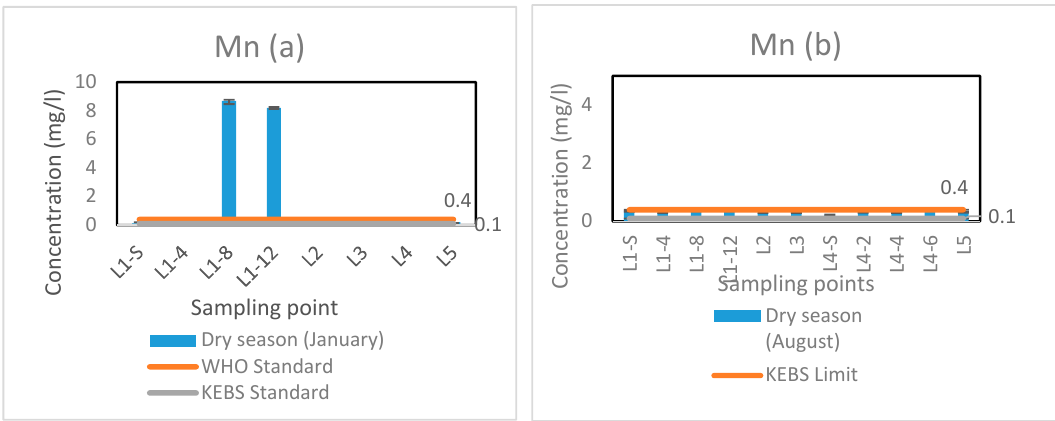
Figure 11. Manganese concentration at various sampling points: ( a ) January and ( b ) August. The mean concentrations for Fe, Mn, and Cd were 0.32 mg/L, 2.26 mg/L, and 0.008 mg/L,